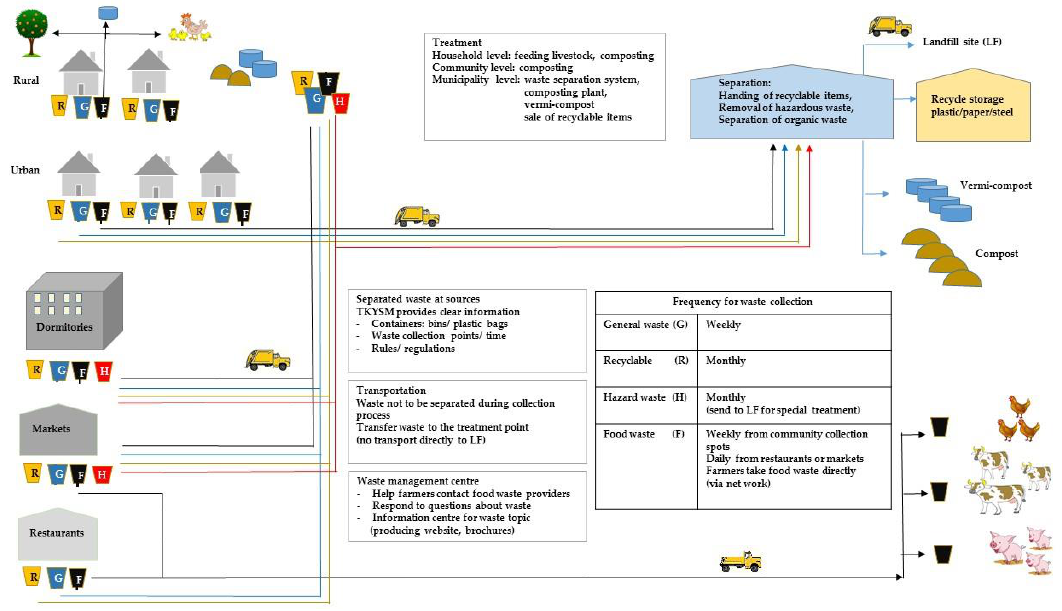
Figure 5. A schematic approach to waste separation components.